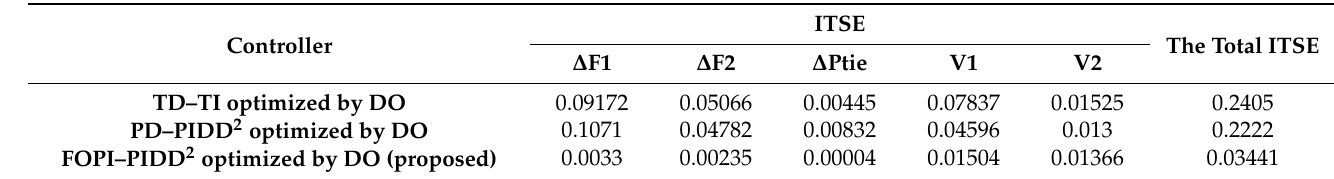
Table 6. Dynamic specifications of the investigated system represented as ITSE value using different controllers under scenario 4 impact.